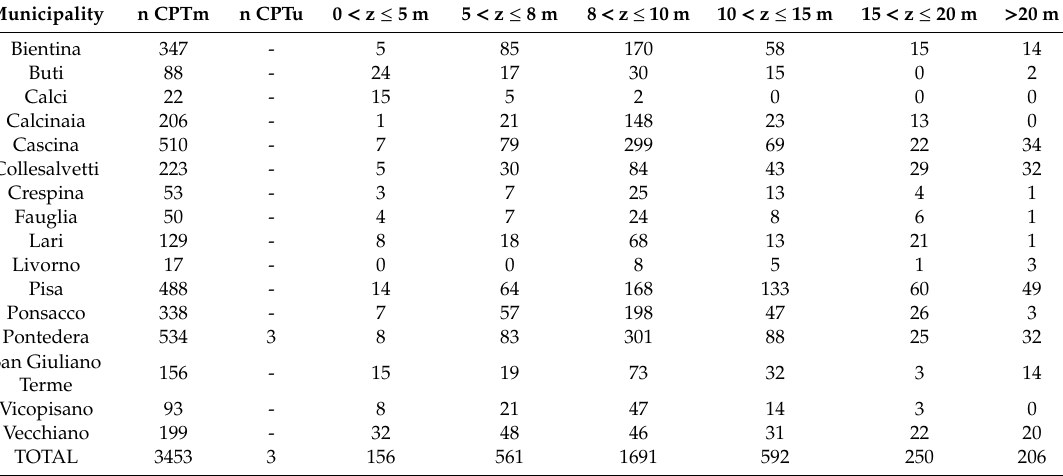
Table 2. CPT database for the macro-area of the Pisa plain.